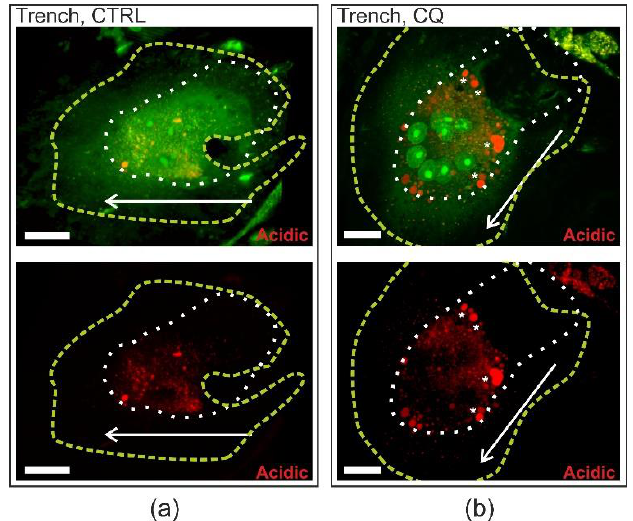
Figure 7. Chloroquine seems to cause an enlargement of acridine orange stained vesicles in OCs making trenches. ( a ) A 3D confocal view of trench-forming OC in the control condition. ( b ) A 3D confocal view of a trench-forming OC treated with 10 µM chloroquine. Circumference of OCs are indicated by a green dashed line, while the edge of the resorptive cavities is shown with a white dashed line. The direction of resorption is indicated with an arrow. Acridine orange turns red/orange in acidic compartments, while in more neutral compartments it is green. The white bars represent 20 µm.